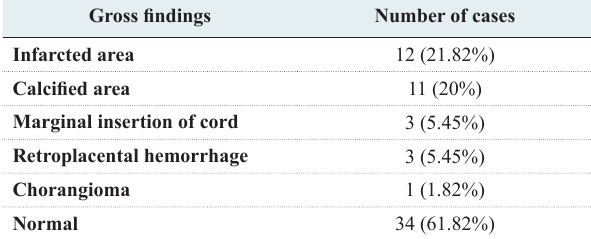
Table 2: Gross Anatomy of